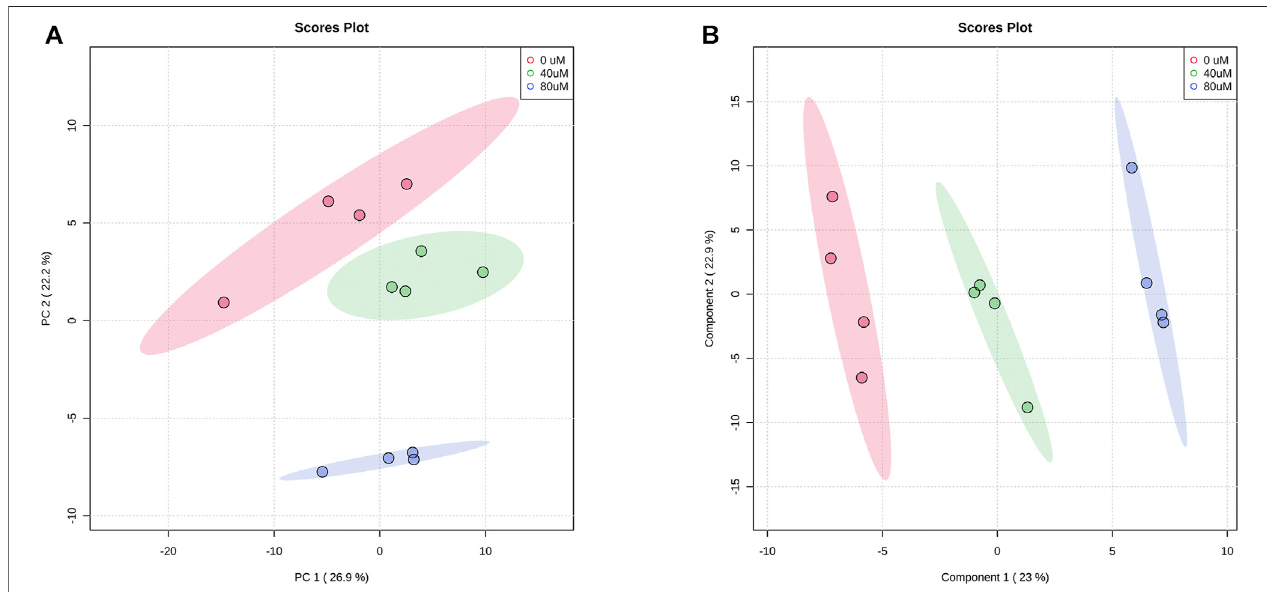
FIGURE 2 | Score plots of PCA (A) and PLS-DA (B) models for the metabolome data obtained by LC-MS, showing the metabolic pro fi le differences between control and EGCG-treated groups. Red cycle: control group; green cycle: 40 μ M EGCG-treated group; blue cycle: 80 μ M EGCG-treated group.